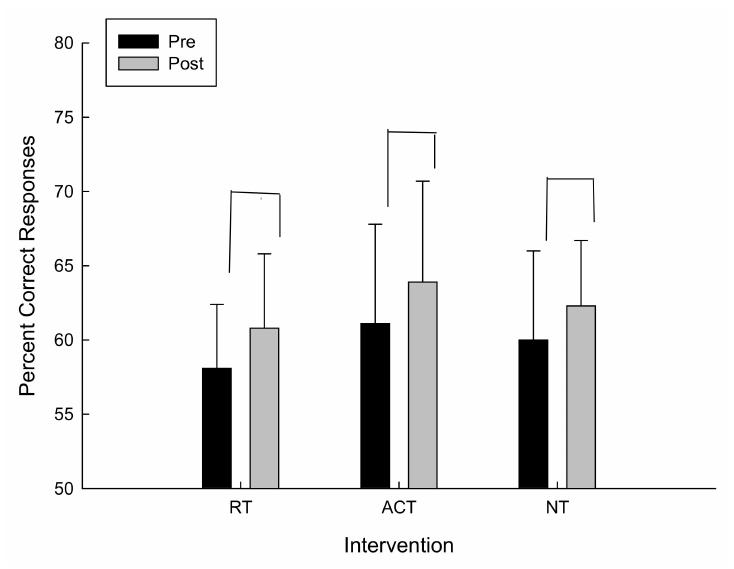
Figure 2. Percent correct responses as a function of intervention and time.